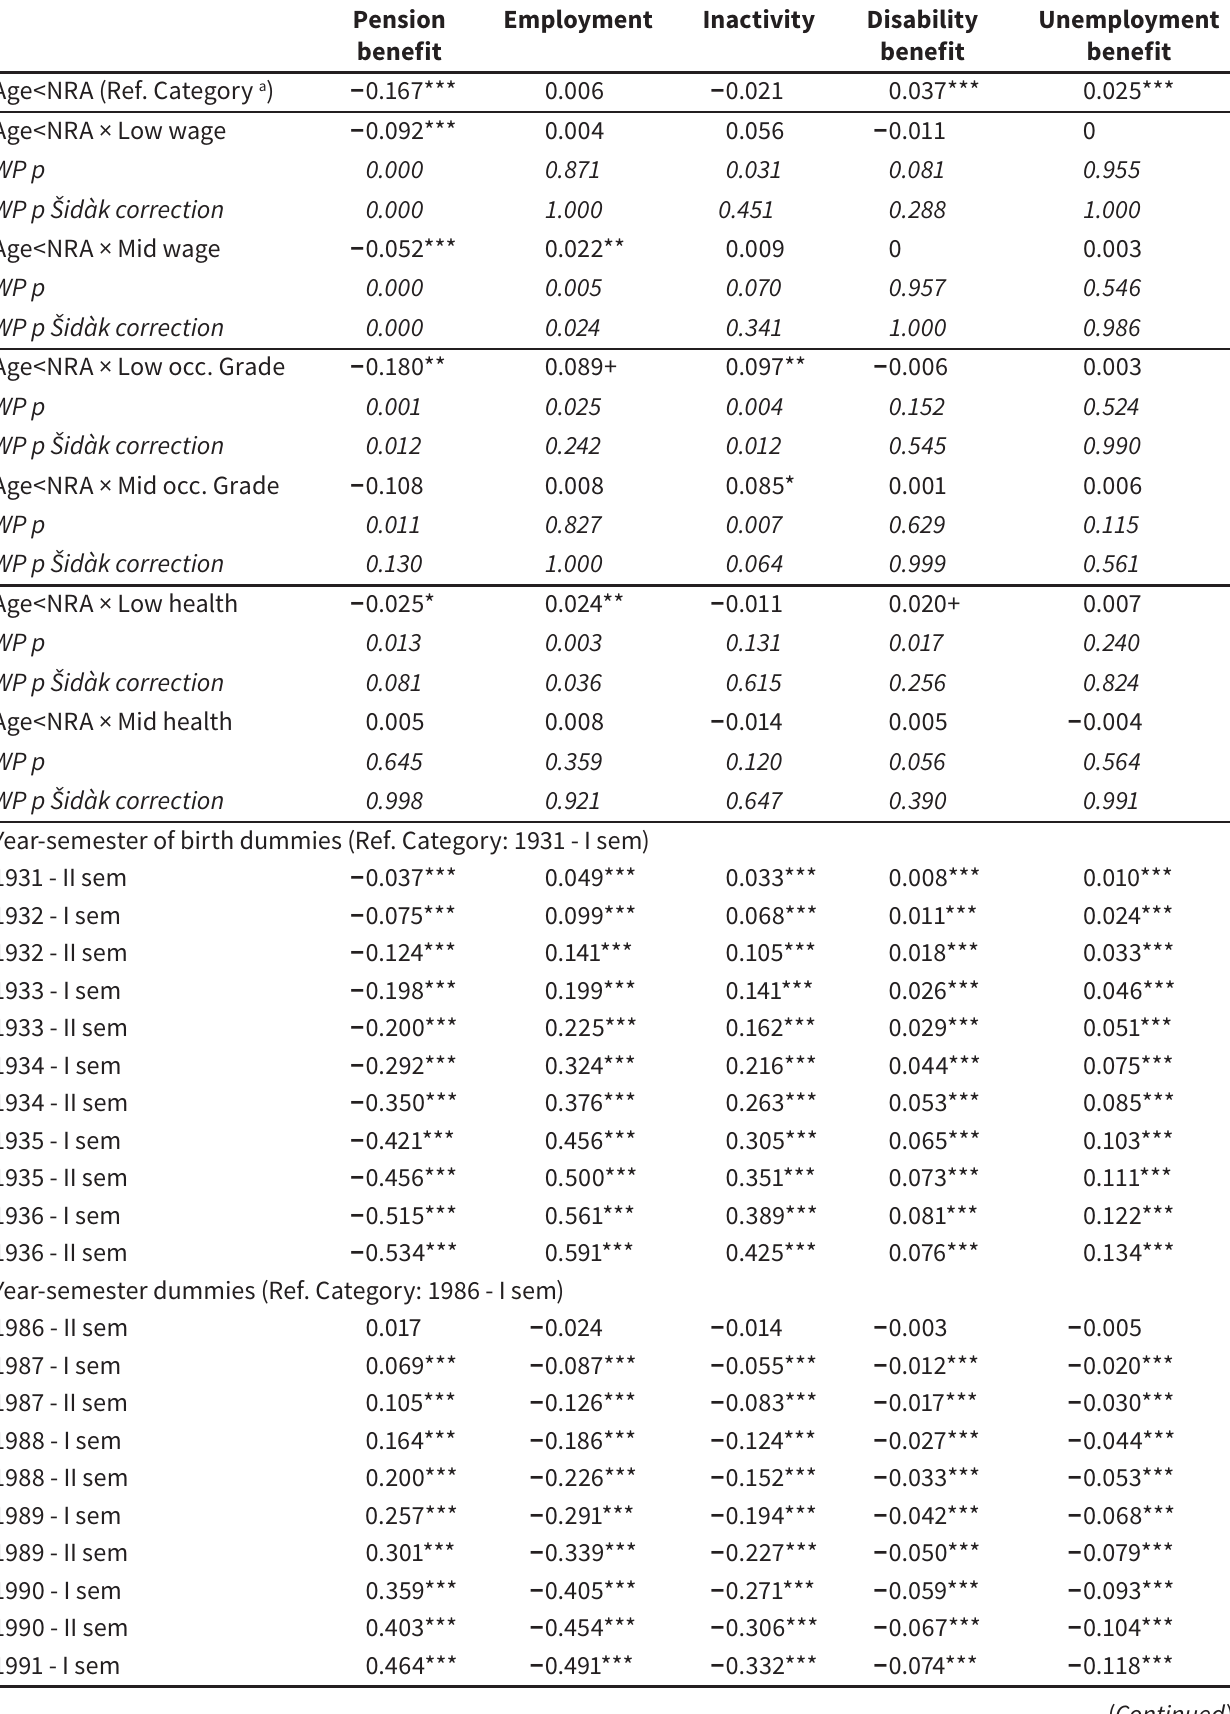
Table C3 Heterogeneous effect of rising the NRA: fully interacted analysis (based on Eq. (2))